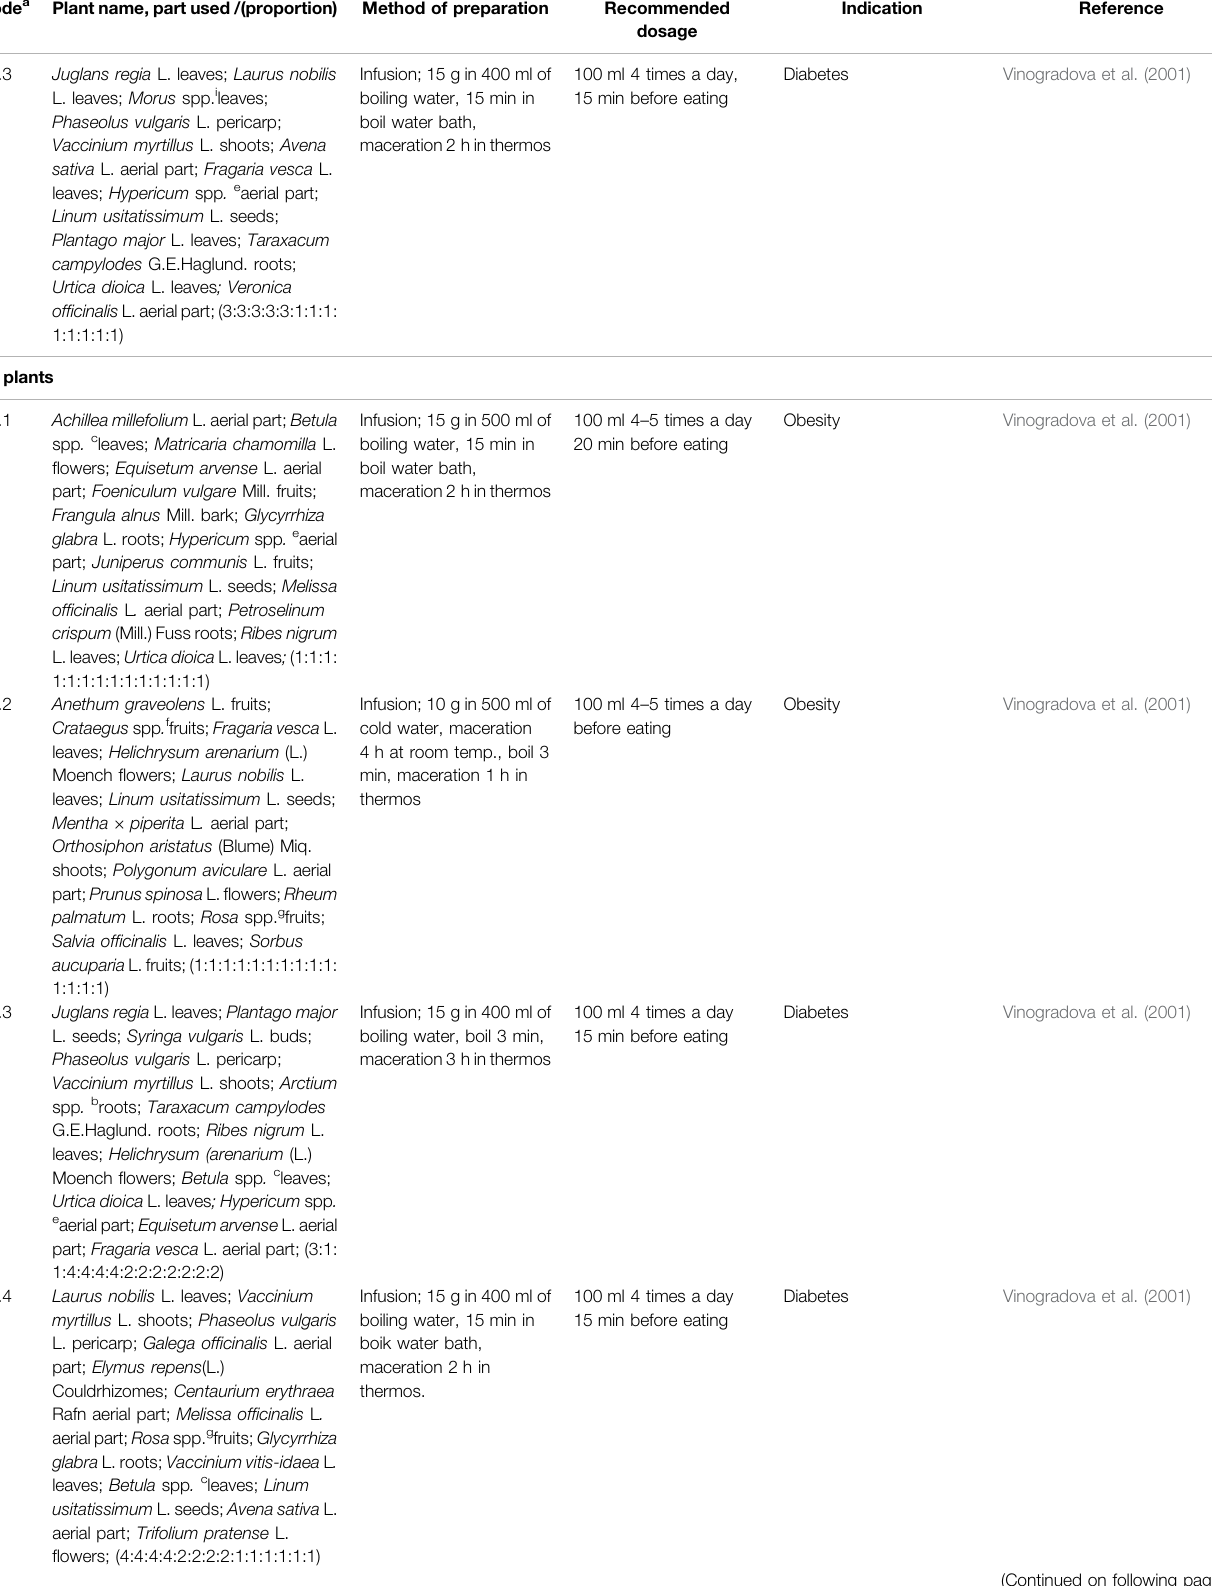
TABLE 1 | ( Continued ) The list of medical species used for the management of diabetes and related disorders in Russia. Code a Plant name, part used /(proportion) Method of preparation Recommended